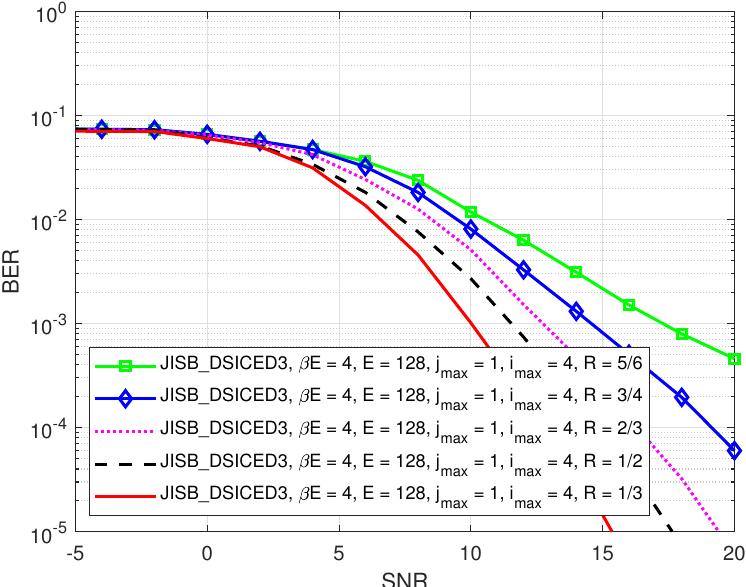
Figure 8. BER versus SNR, p B / σ 2 w for different code rates R of the JISB_DSICED3 scheme; i max = 4, j max = 1, p SI / σ 2 w = 30 dB, β E = 4 symbols, and E = 128